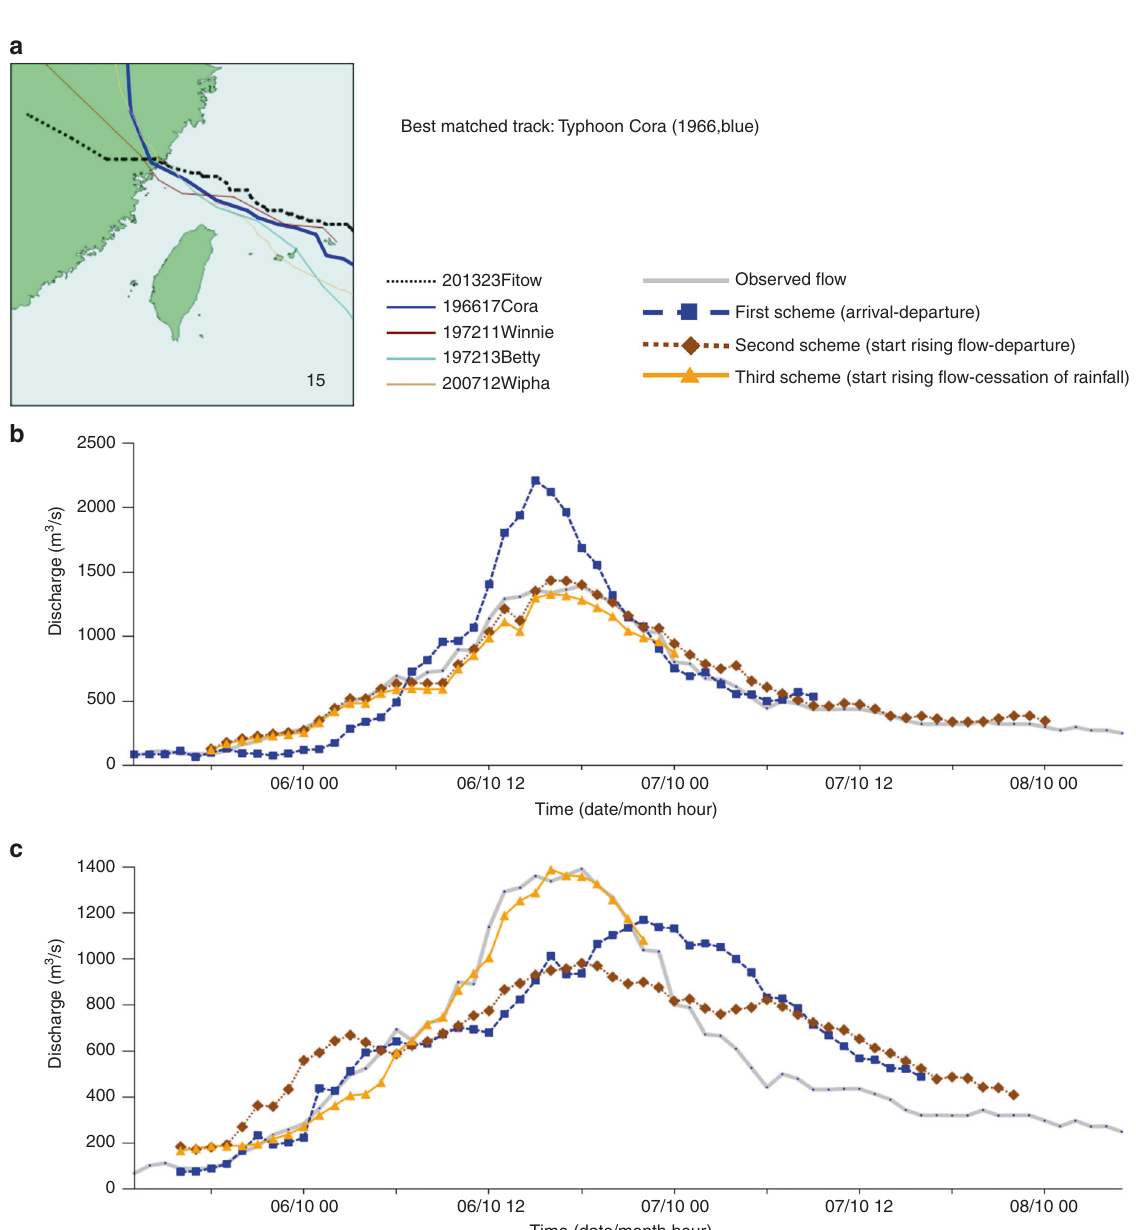
Fig. 7 Predicted fl ood hydrographs for Typhoon Fitow. Predictions were made using two fl ow characteristic curve selection strategies under three typhoon duration schemes. a Actual typhoon tracks grouped in cluster #15. This is the best matched cluster while Typhoon Cora, the best matched track, has a track the most similar in shape to the track of Typhoon Fitow. b Predicted fl ood hydrographs using the fi rst selection strategy. This strategy selects the fl ow characteristic curve of the best matched track. c Predicted fl ood hydrographs using the second selection strategy. This strategy selects the ensemble of all fl ow characteristic curves in the best matched cluster. We use three schemes to characterize typhoon duration. The fi rst scheme spans between the arrival and departure time of a typhoon over the gridded zone. The second scheme spans between the start rising fl ow limb characteristics and the departure of the typhoon from the gridded zone. The third scheme spans between the start rising fl ow limb characteristics and the cessation of